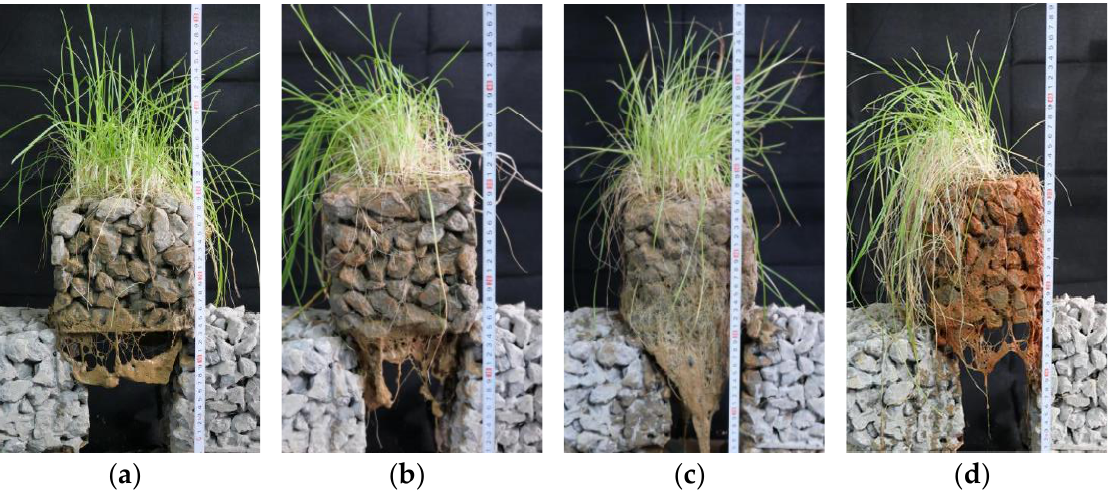
Figure 15. Fifty-day root system of tall fescue plant growth. ( a ) Mixed planting of 4.5 g seeds. ( b ) Mixed planting of 9 g seeds. ( c ) Surface planting of 4.5 g seeds. ( d ) Surface planting of 4.5 g seeds.